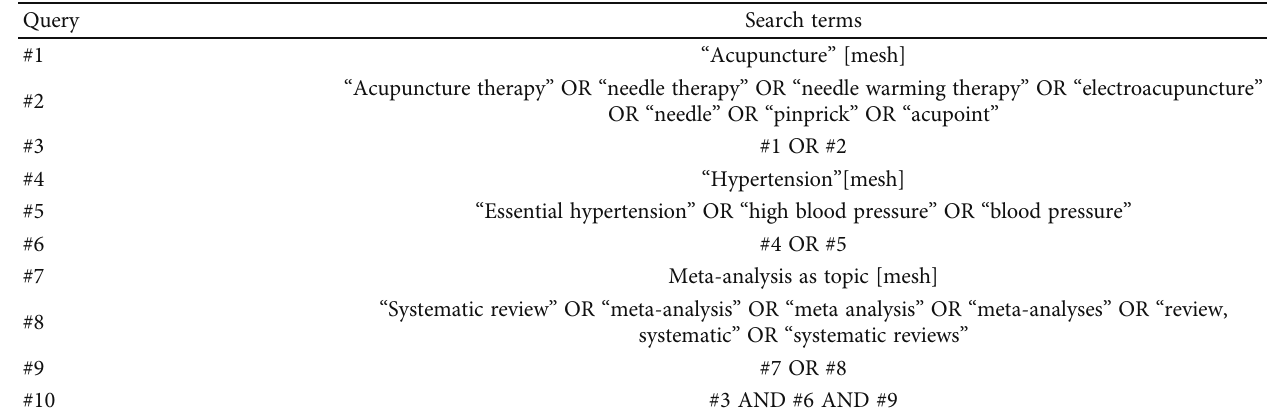
Table 1: Search strategy for the PubMed